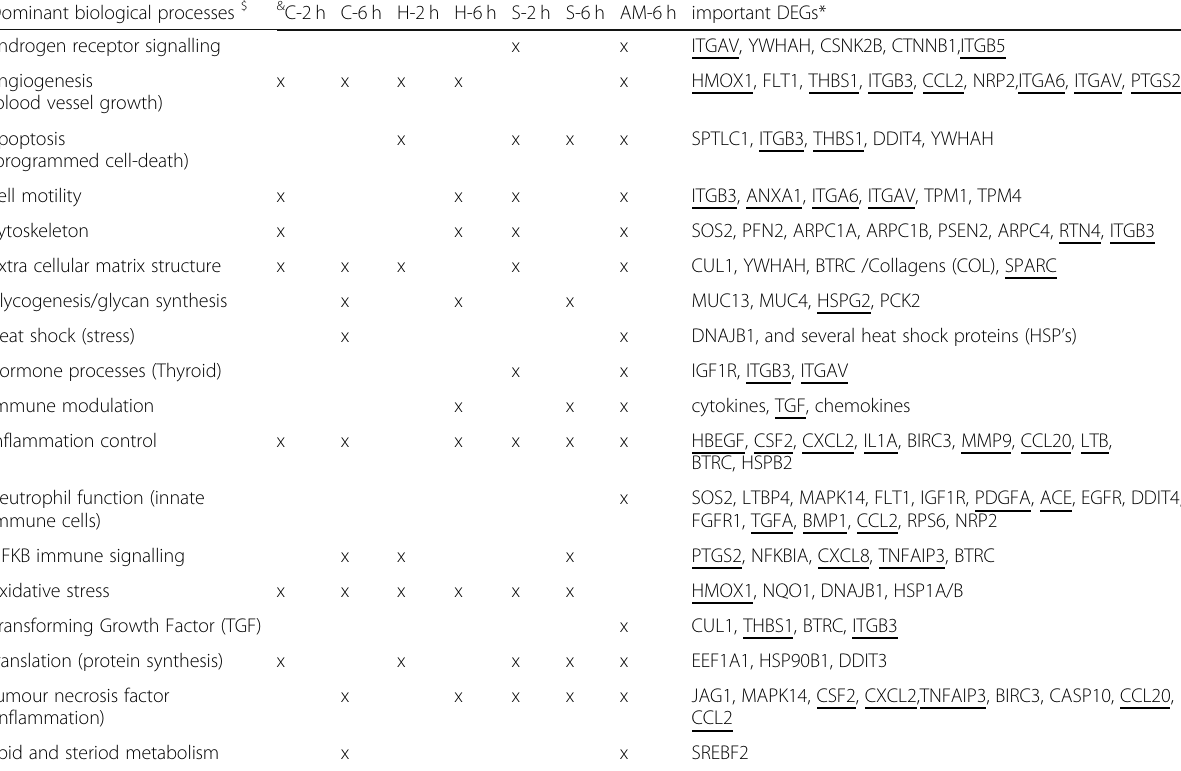
Table 3 Dominant biological processes regulated by algae extracts in the absence of ETEC Dominant biological processes